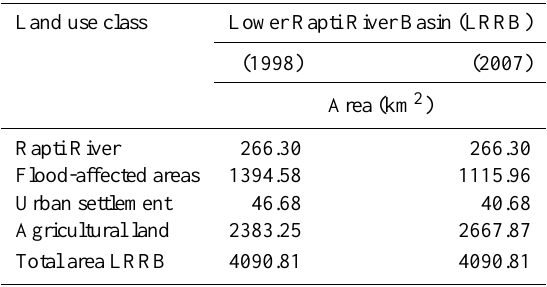
Table 1. Flood risk in and around the Gorakhpur urban